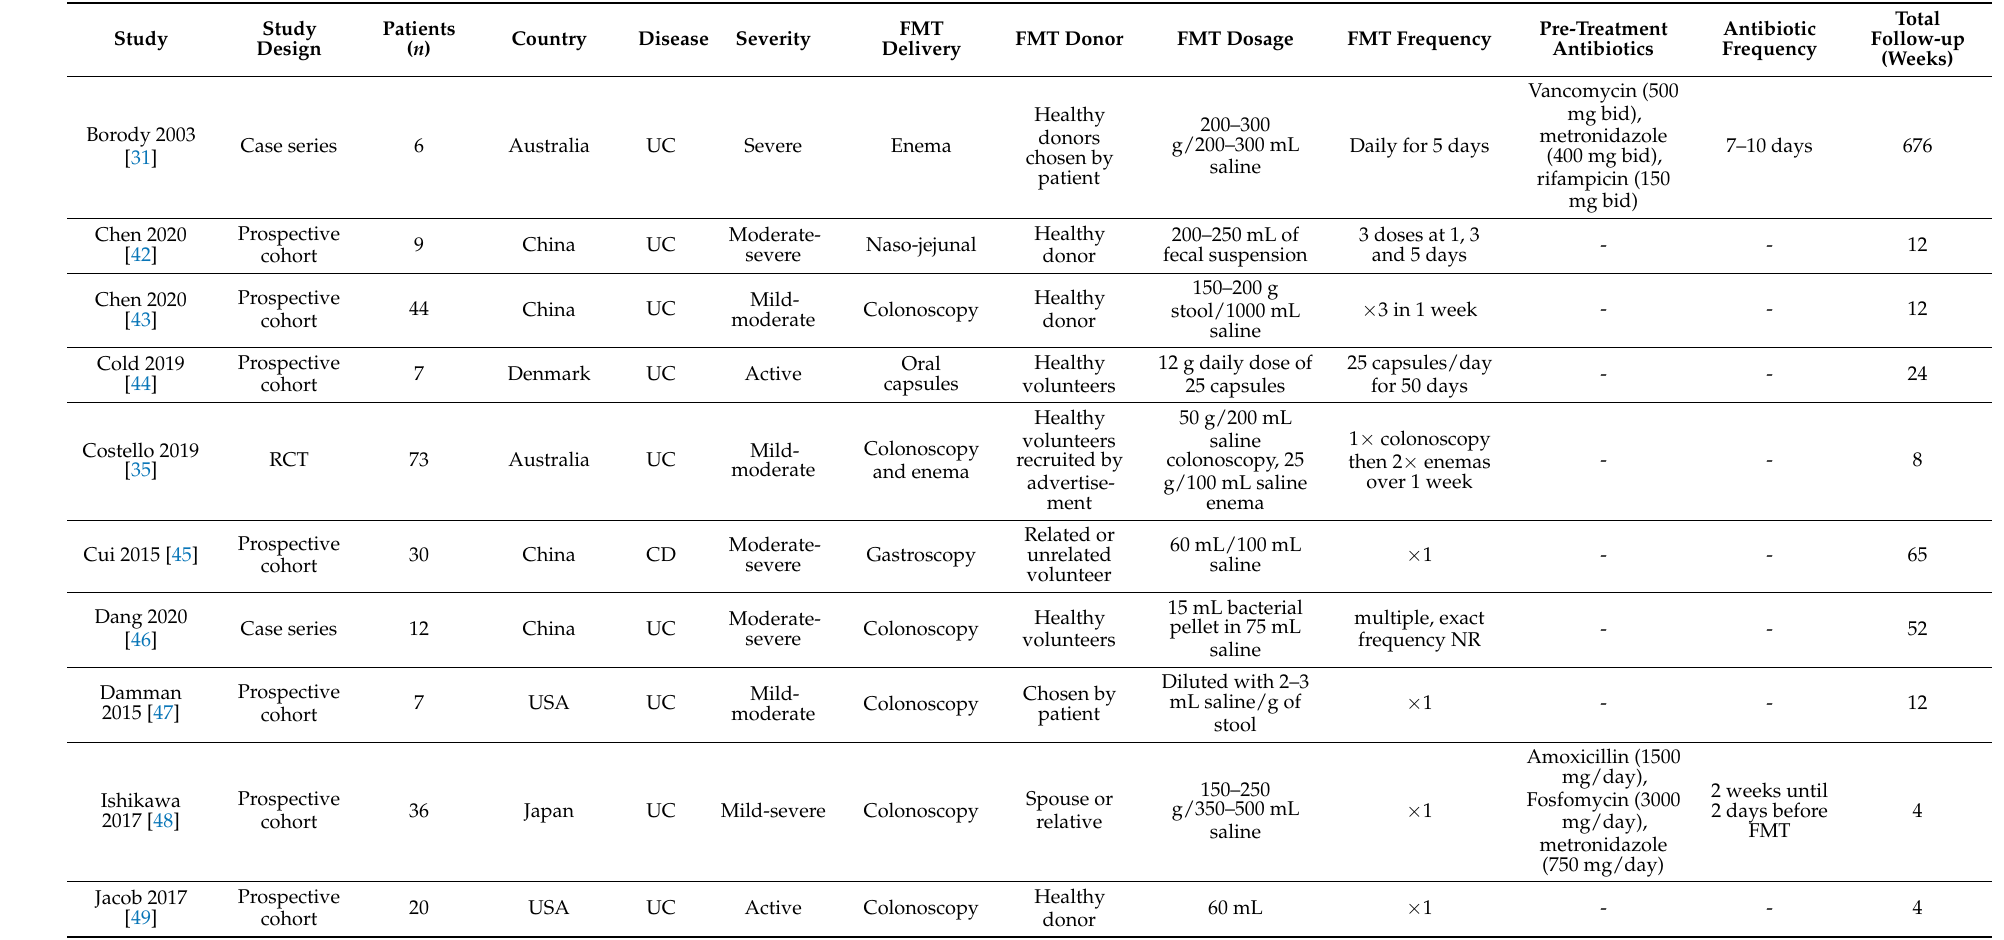
Table 1. Study design and FMT regimen